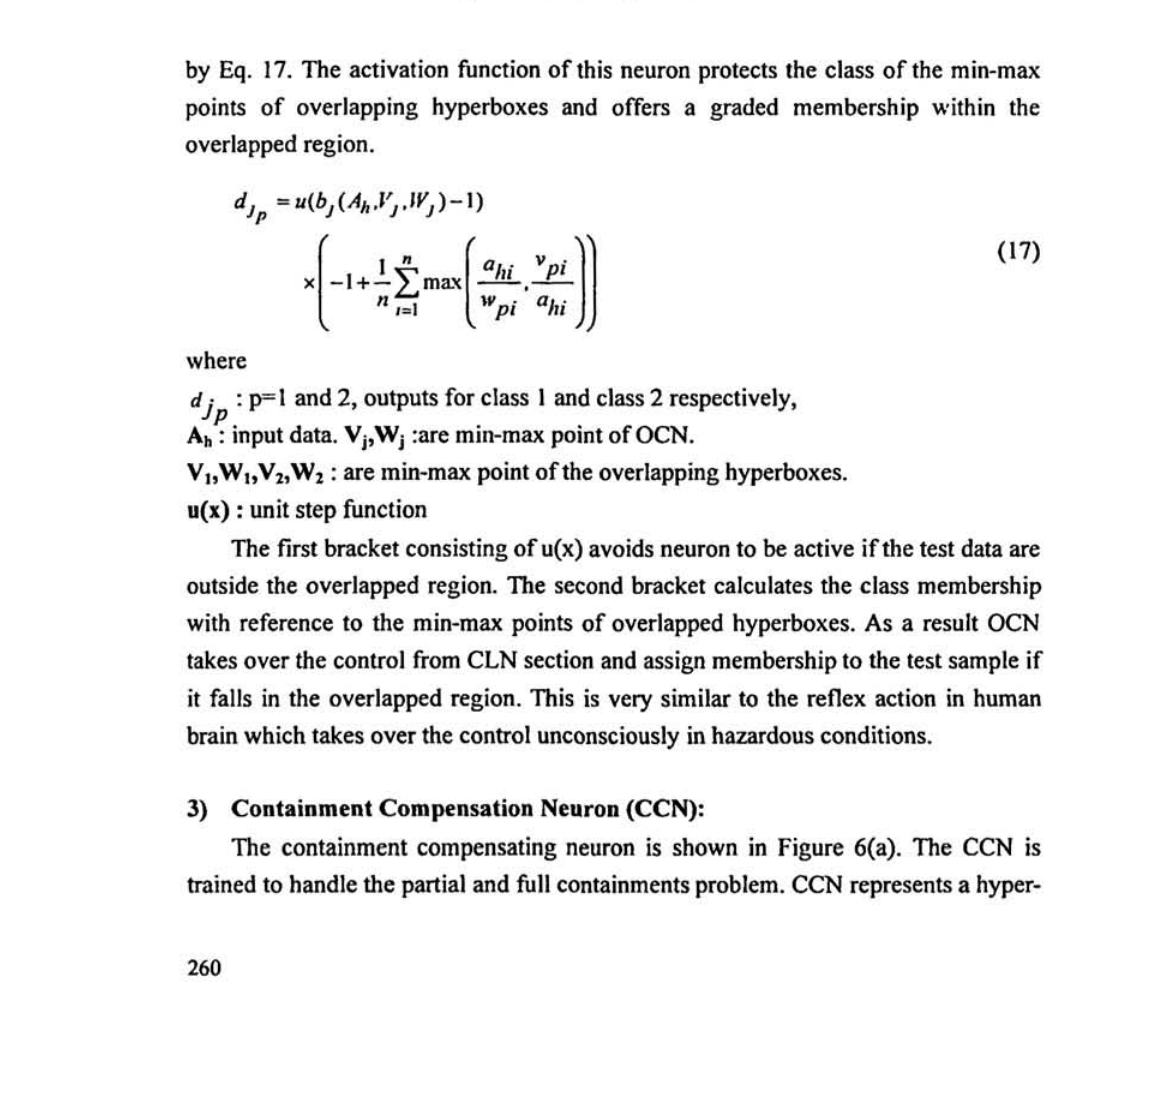
Fig. 5: Overlap compensation